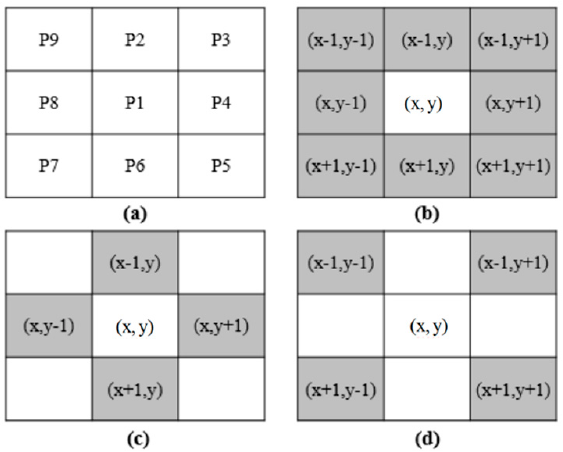
Figure 5. The result after adaptive threshold segmentation.